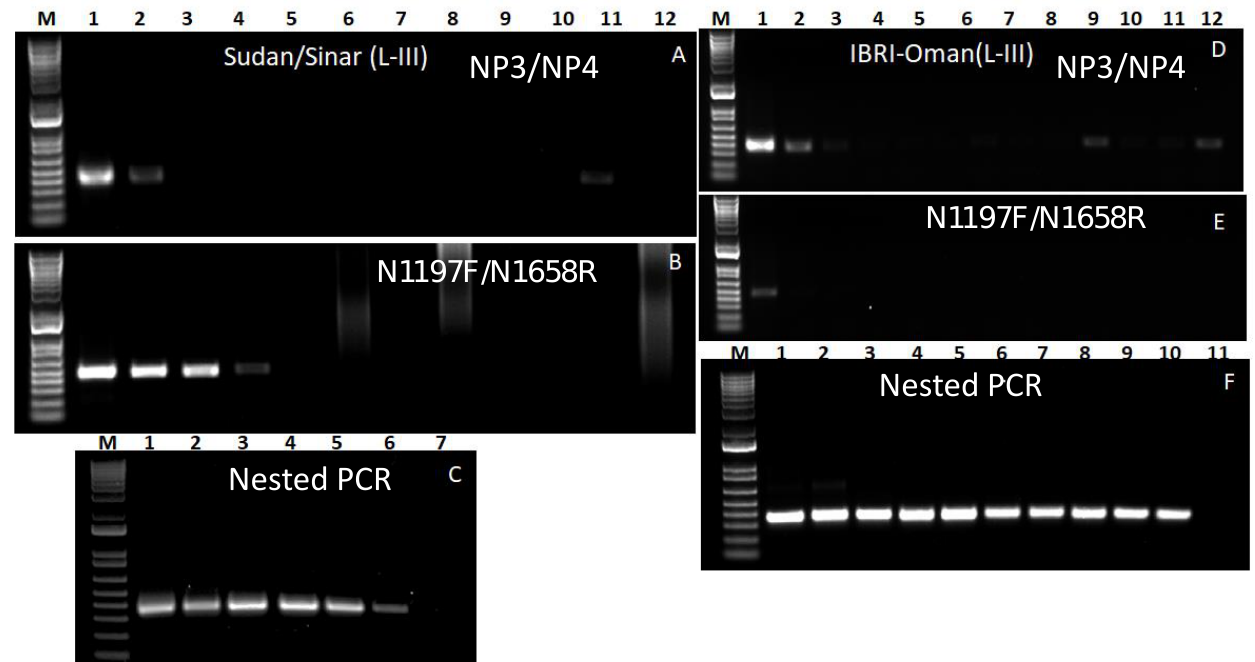
Figure 3. Gel images of PCR products using RNA of Linage III viruses Sudan/Sinar 1972 ( A – C ) and IBRI-Oman 1982 ( D – F ). ( A , D ): PCR products obtained from first round of PCR using primer pair NP3/NP4, ( B , E ): PCR products obtained from first round of PCR using primer pair N1197F/N1658R, ( C , F ): PCR products obtained from nested PCR using primer pair NP3/NP4. M: 1 kb plus marker DNA; lanes 1–12 in A , B , D , E correspond to neat, 10 −1 to 10 −11 RNA, respectively. Lanes 1–7 in C correspond to 10 −3 to 10 −9 RNA, and lanes 1–11 in F correspond to neat, 10 −1 to 10 −10 RNA, respectively.